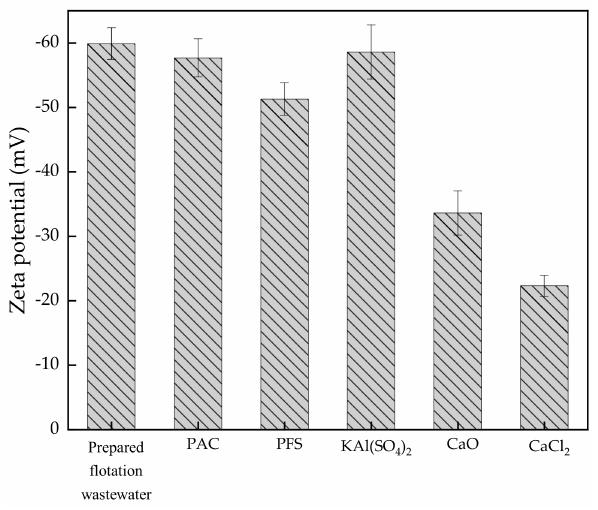
Figure 5. Zeta potential of prepared flotation wastewater treated by different